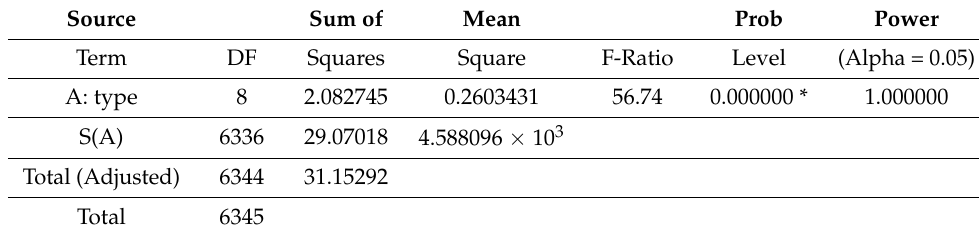
Table 9. Analysis of Variance Table.